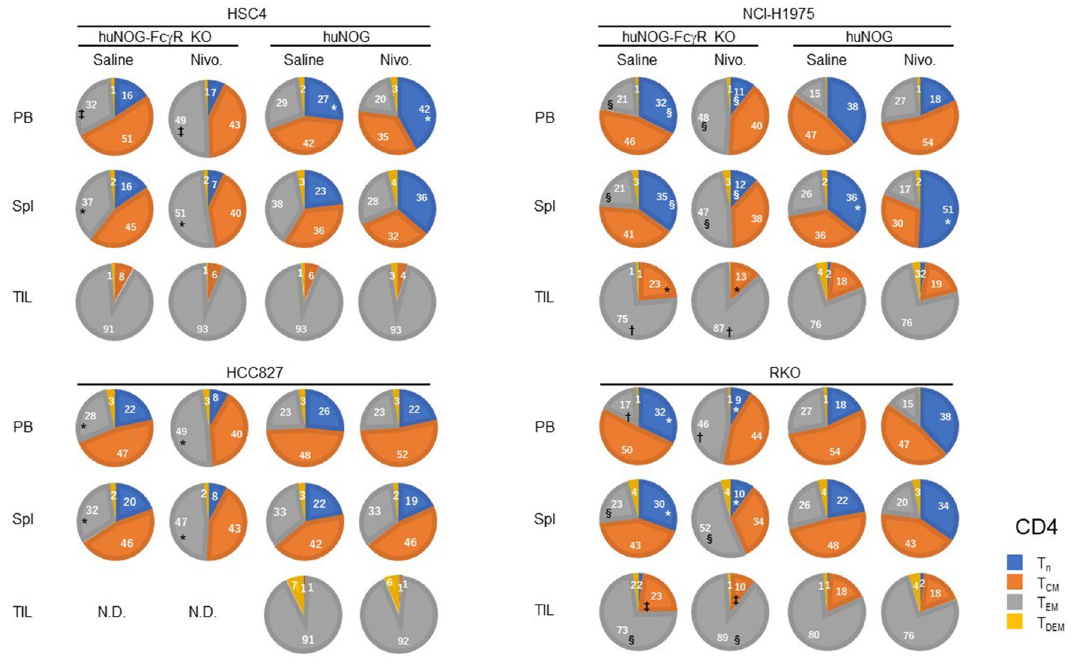
Figure 7. Alternations of CD4 + T cell subsets by nivolumab in huNOG-FcγR −/− mice. The proportions of CD4 + T cell subsets were obtained from flow cytometry analyses in Fig. 6. The results of the frequencies (Supplementary Fig. 10) and cell numbers (Supplementary Fig. 11) of the T-cell subpopulations are summarized in the pie charts. Data from a representative experiment are shown for each tumor cell line. The value indicates the average. A statistical significance between the corresponding T-cell subsets in saline-treated and nivolumab- treated mice was indicated by a pair of symbols as listed below. Statistical significance was tested using two-way ANOVA with Sidak’s multiple comparison test (*p < 0.05, † p < 0.01, ‡ p < 0.001, § p < 0.0001).